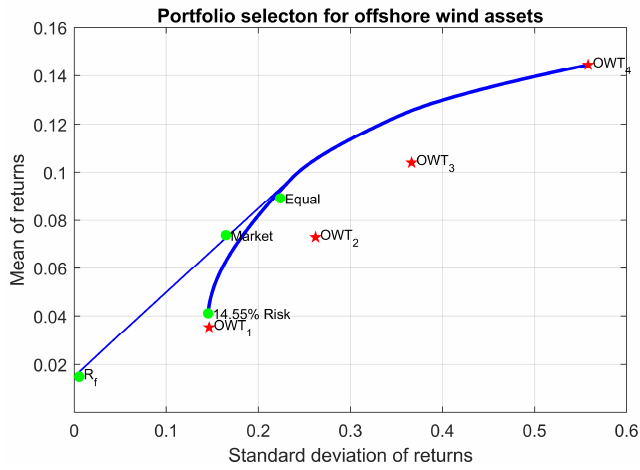
Figure 12. Mean value of ROI as a function of standard deviation, minimum risk (14.55%).